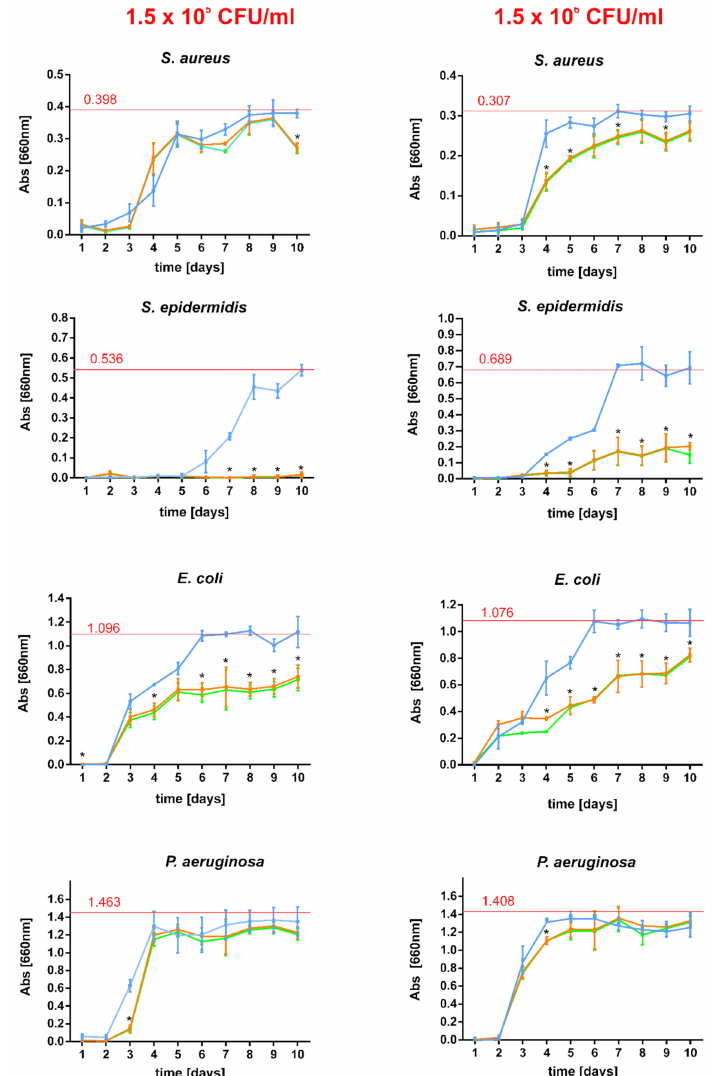
Figure 9. Long-term antibacterial activity of gentamicin-bound Coll+G, Coll+PLD+G and Coll+PLD+G+Glyc prostheses against four reference strains. The results are presented for extracts of prosthesis collected daily during a 10 day-long test and inoculated with bacteria (with initial density: 1.5 × 10 5 /mL or 1.5 × 10 6 /mL). The growth was expressed as culture absorbance at 660 nm and compared with averaged bacterial growth in control culture medium (100% growth—red line, with absorbance value marked over the line). Blue solid line—Coll+G; orange solid line—Coll+PLD+G; green solid line—Coll+PLD+G+Glyc. (*) symbol indicates statistically significant results for Coll+G prosthesis in comparison to Coll+PLD+G and Coll+PLD+G+Glyc, according to one-way ANOVA with post-hoc Tukey’s test ( p <